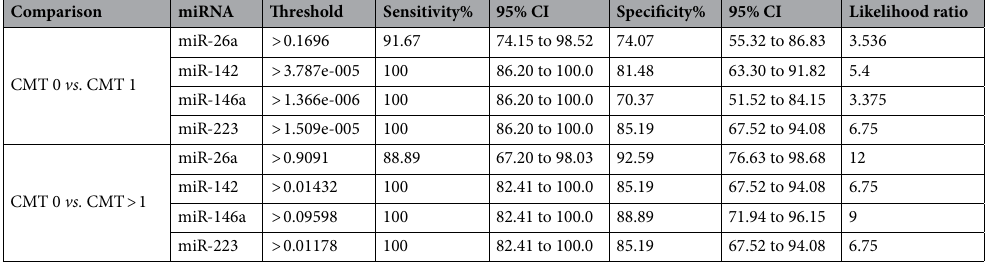
Table 4. Threshold, sensitivity and specificity values for each miRNA based on ROC curve analyses. Data with the highest combined values of sensitivity and specificity obtained for each miRNA are